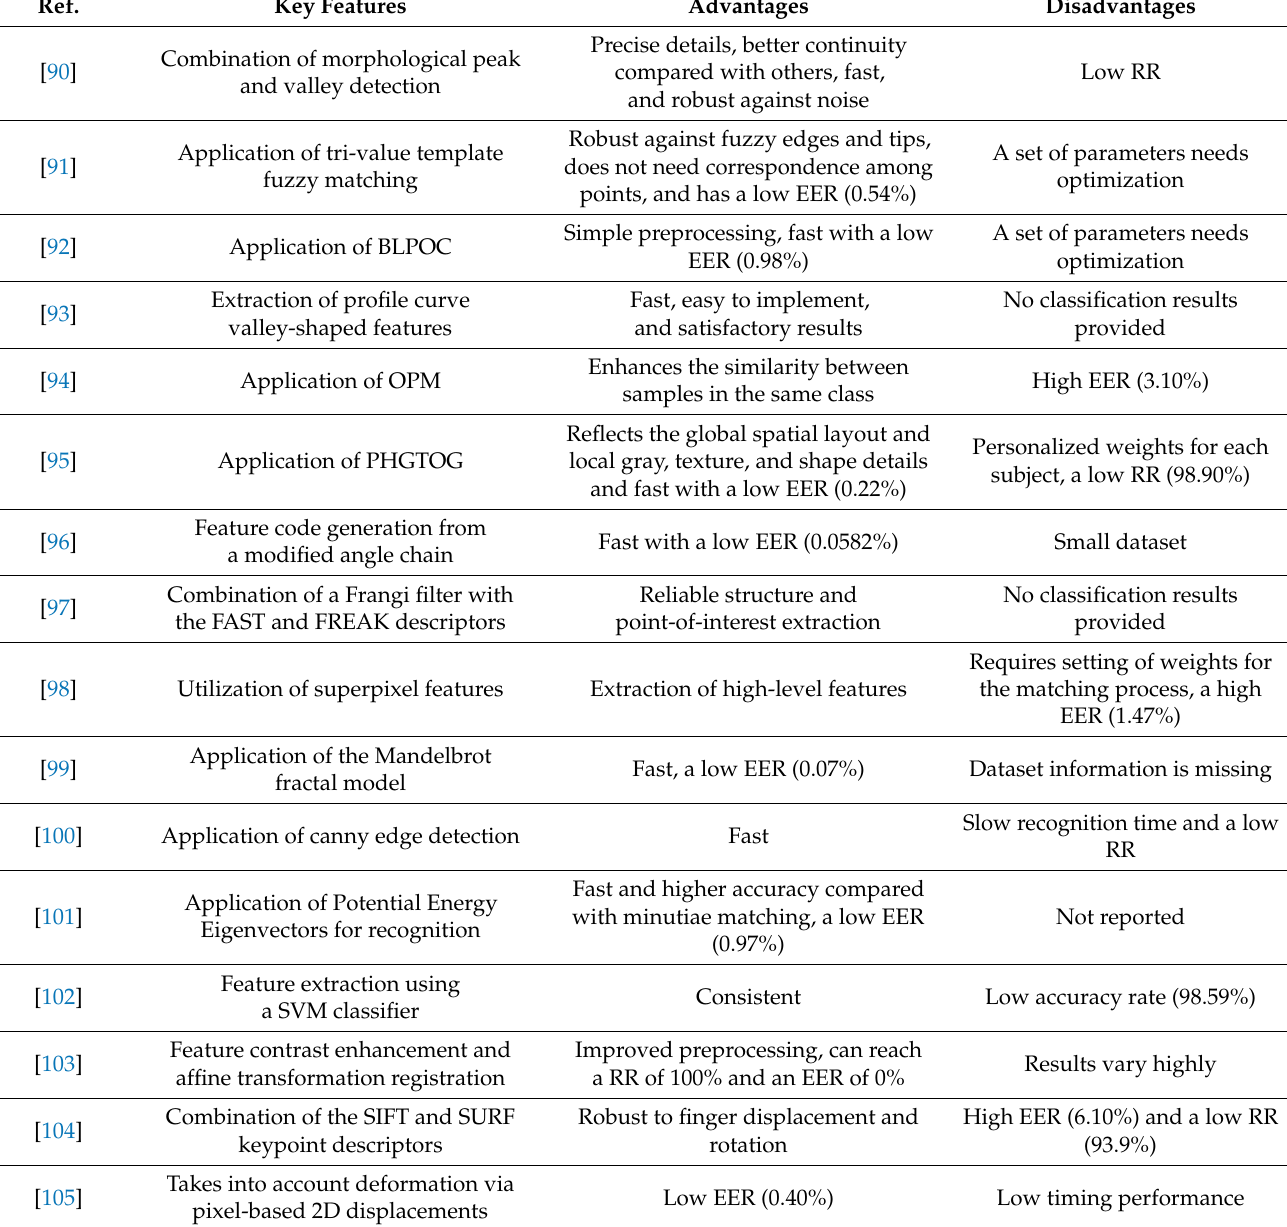
Table 5. Characteristics of the remaining feature extraction